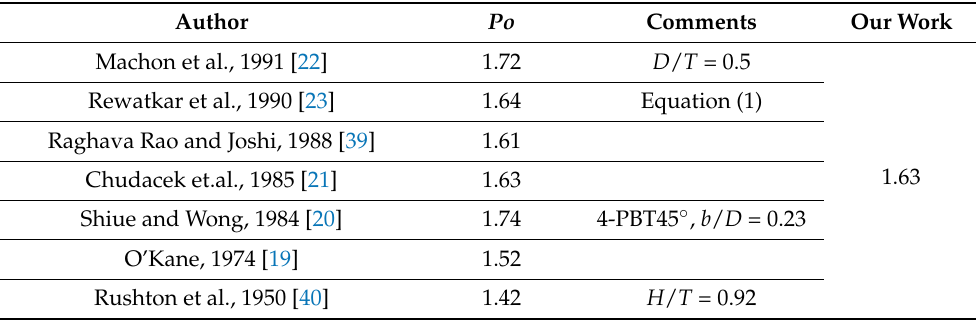
Figure 2. The power of mixing single impellers and a system of two impellers 6-PBT45°. For the upper single impeller, the value of the power number was obtained as Po up = 1.58, while for a single lower impeller, a similar value 3.5% higher was obtained, Po down = 1.63. The relation obtained of the Po value is consistent with the research of many authors [21,23,25,37]. Table 1 shows a comparison of the Po down value for the lower impeller with the results of other authors. Table 1. Comparison with other authors’ results for the agitator 6-PBT45° ( D / T = 1/3, y 1 / T = 1/3, b / D = 0.2) for turbulent mixing range.